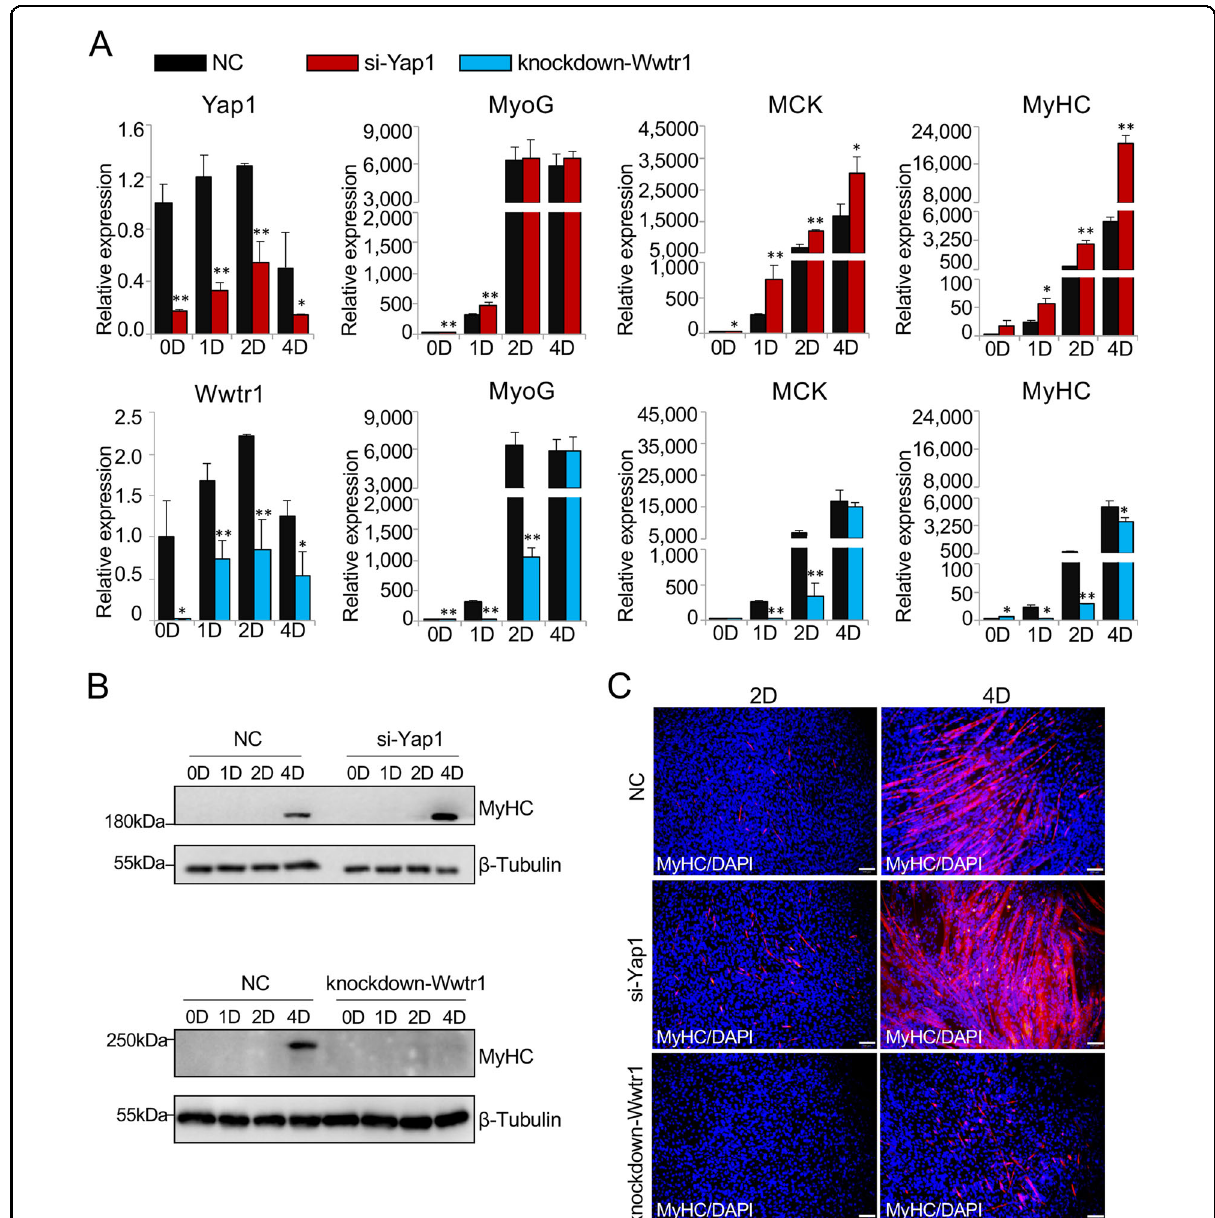
Fig. 6 Regulation of myogenic differentiation of C2C12 myoblasts by the Hippo signaling pathway. a mRNA expression patterns of genes on days 0, 1, 2, and 4 of cell differentiation via Q-PCR after inhibiting Yap1 with speci fi c siRNAs (si-Yap) or repressing Wwtr1 via CRISPR/Cas9 editing (knockdown-Wwtr1) in C2C12 myoblasts. The expression fold change is relative to wild-type C2C12 myoblasts on day 0 of culture in GM (NC). b , c The protein expression pattern of MyHC during cell differentiation in the si-Yap1, knockdown-Wwtr1, and NC groups as determined via western blotting and immuno fl uorescence. Myotubes were visualized with an anti-fast myosin antibody (red). Nuclei were stained blue with DAPI. Scale bars: 100 μ m. Magni fi cation: ×100. * p < 0.05; ** p <